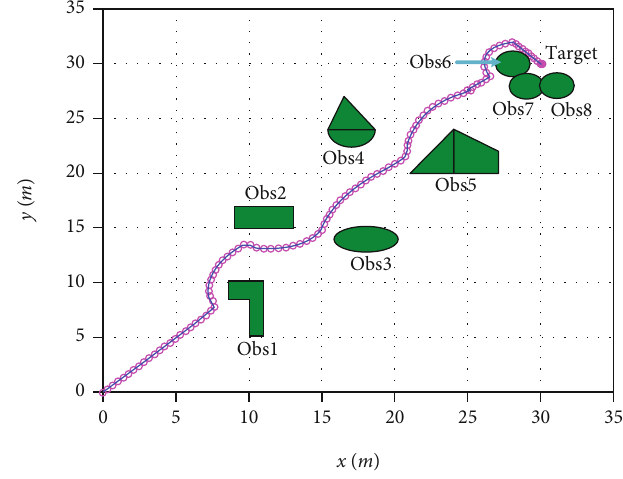
Figure 10: Scenario 3: the result of path planning of the proposed algorithm in a complex